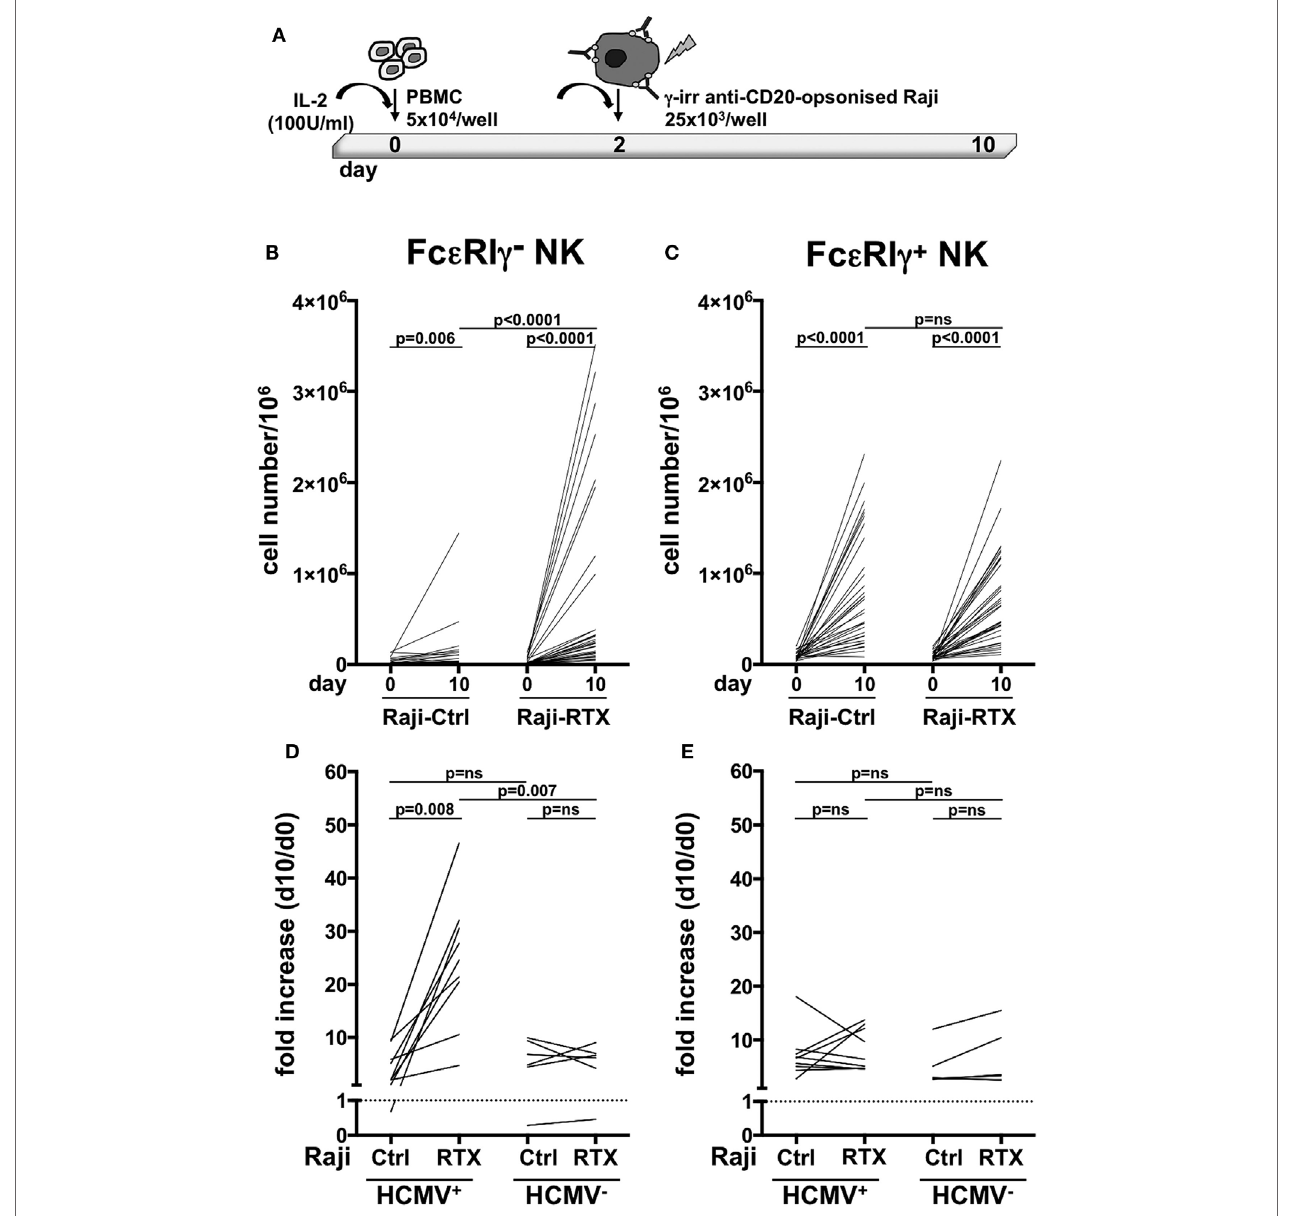
FigUre 2 | In vitro memory natural killer (NK) cell expansion upon interaction with rituximab-opsonized Raji lymphoblastoid cells. (a) Experimental setting of NK cell co-culture protocol. (B) Memory (Fc ε RI γ − ) and (c) conventional (Fc ε RI γ + ) CD3 − CD56 dim CD16 + NK cell numbers (per million mononuclear cells), at the start (day 0) and at the end (day 10) of co-culture with Raji cells, opsonized (RTX) or not (Ctrl) with rituximab anti-CD20 monoclonal antibody (mAb). (D) Memory (Fc ε RI γ − ) and (e) conventional (Fc ε RI γ + ) NK cell fold increase from individuals with less than 3% of memory NK cells. Donors were stratified according to human cytomegalovirus (HCMV) seropositivity status. Dotted line marks the value of 1. p values of pairwise comparisons are from Wilcoxon and Mann–Whitney non-parametric tests, as